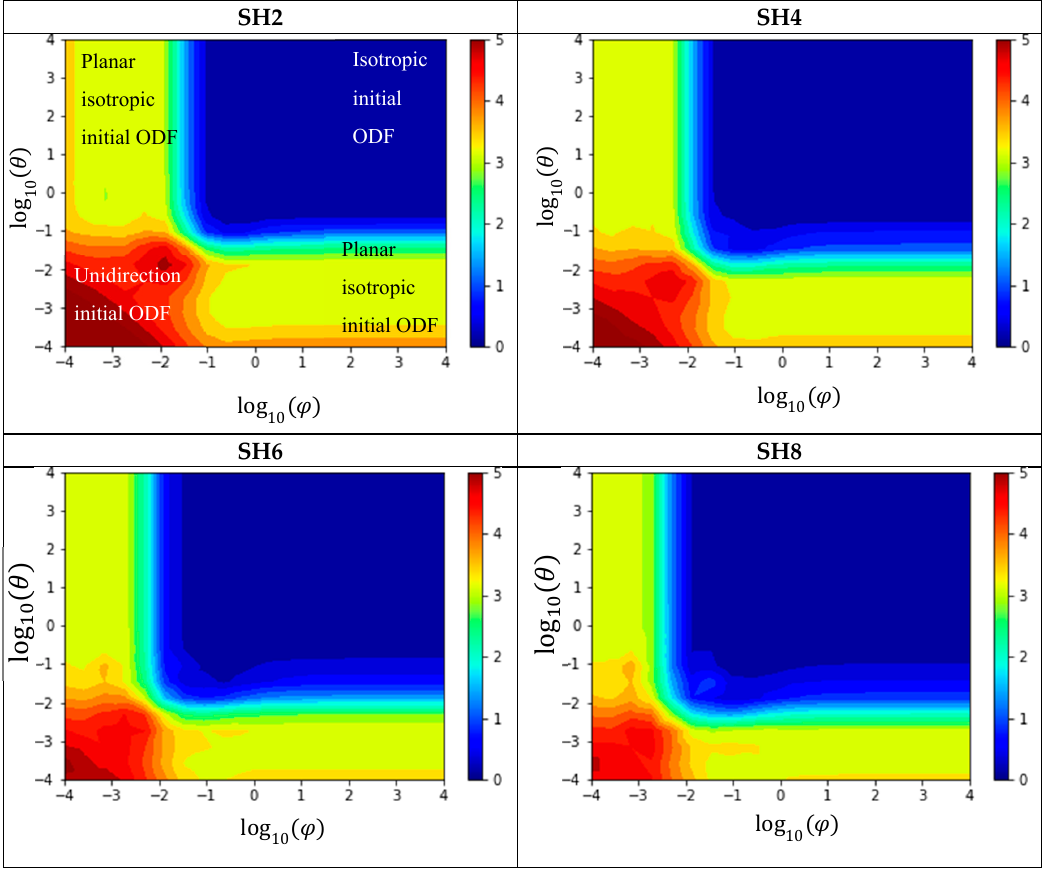
Figure 9. Color plot of the Kullback–Leibner distance in dependency of covariance (SH2, SH4, SH6, and SH8).